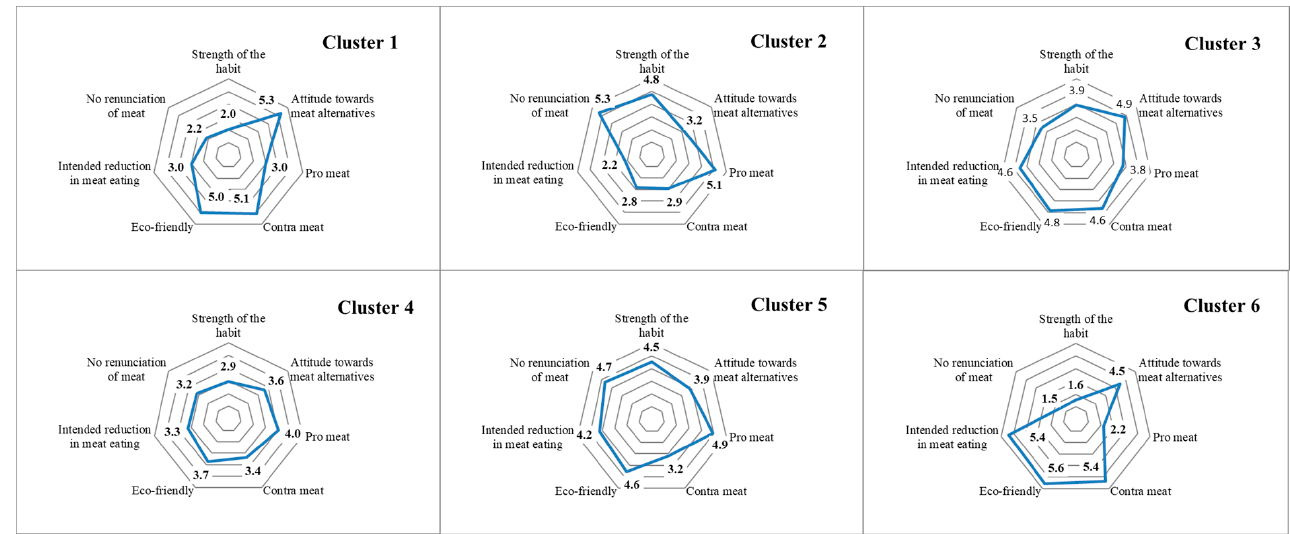
Figure 1. Graphical representations of the six identified clusters for the clustering scales and their means. For the items of all the scales, the agreement was queried as follows: 1—Do not agree at all, 6—Strongly agree. Table 2. Cluster names and shares.